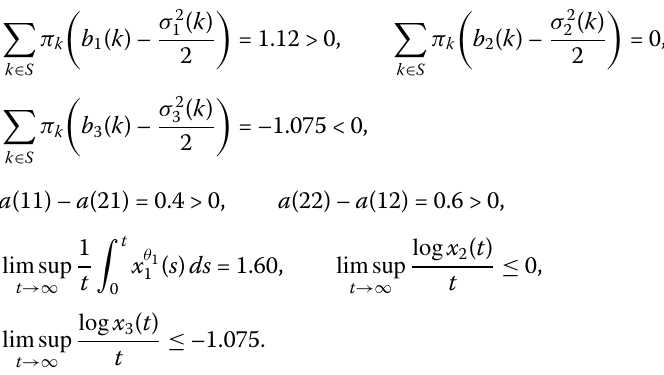
σ σ 3 (1) = 2, 1 (2) = 0.4,